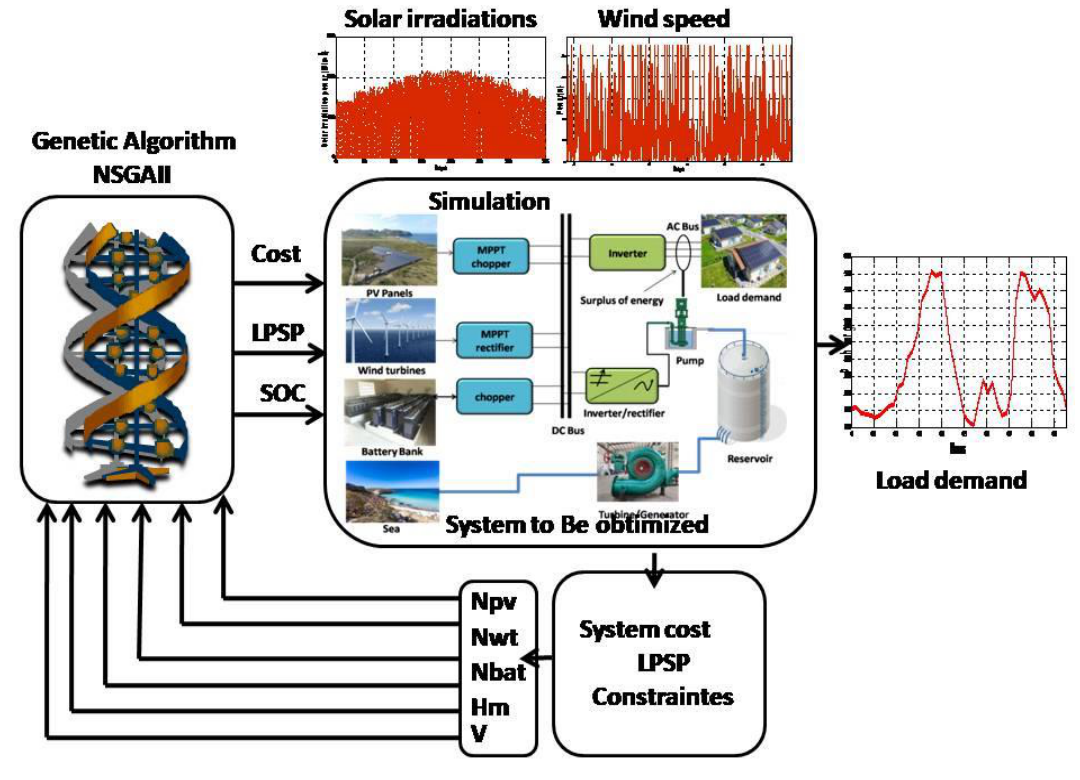
Figure 13. Optimization process.